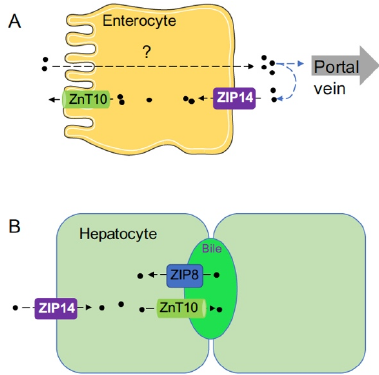
Figure 2. Schematic diagram illustrating the functions of ZIP8, ZIP14, and ZnT10 in enterocytes and hepatocytes. ( A ) The functions of ZIP14 and ZnT10 in enterocytes. How manganese is absorbed from the apical to the basolateral side is not well understood. ZIP14 plays a role in mediating the re-uptake of freshly released manganese at the basolateral membrane. After being reclaimed by enterocytes, manganese can then be transported back into the intestinal lumen by ZnT10 or remains in the intestine epithelium until it is sloughed. Therefore, loss of ZIP14 will decrease manganese re-uptake and increase the net manganese absorption to induce manganese overload. ( B ) The functions of ZIP14, ZnT10, and ZIP8 in hepatocytes. ZIP14 imports circulating manganese into hepatocytes at the basolateral membrane, while ZnT10 exports manganese into the bile at the apical canalicular membrane. ZIP8 reclaims manganese from the bile to increase hepatic manganese